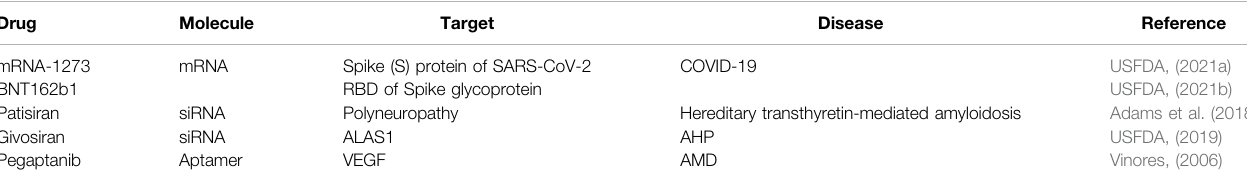
TABLE 4 | Clinically approved RNA